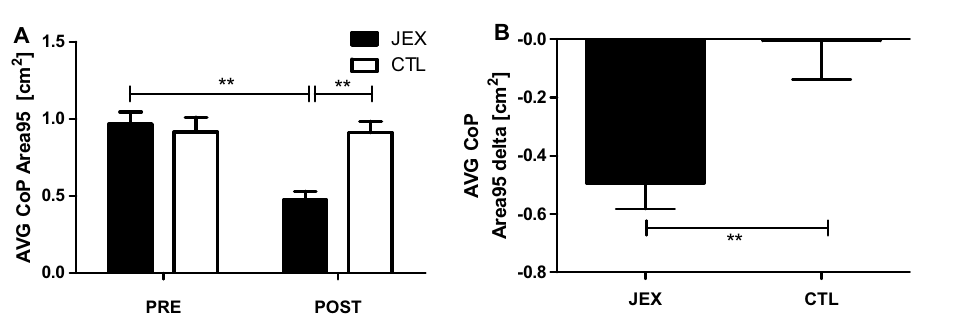
Figure 2. The effect of JEX on postural control, namely AVG CoP Area 95 ( A ), and the contrast between the JEX delta (post–pre) and the CTL delta (post–pre) ( B ). The values represent the mean. The error bars indicate the standard error of the mean. JEX pre vs. post-intervention and post-JEX vs. post CTL **p < 0.001 post hoc Bonferroni test ( A ), contrast between the JEX delta and CTL delta **p < 0.001 Mann–Whitney U test ( B